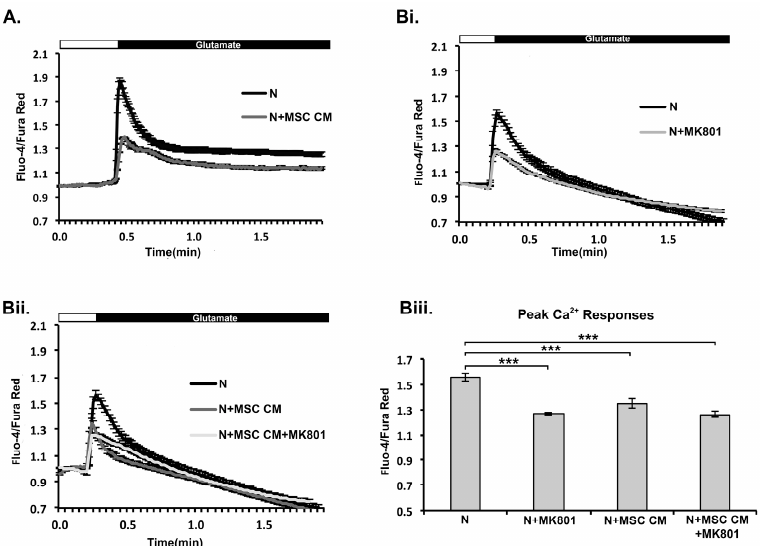
Figure 4. MSC CM-mediated neuroprotection in mouse cortical neurons is associated with reduced glutamate-induced Ca 2+ responses. DIV 9 neurons (N) were pre-treated with MSC CM (24 h) and glutamate-induced intracellular Ca 2+ levels were measured by Fluo-4 and Fura Red imaging. Perfusion of neurons with glutamate/glycine transiently increased Ca 2+ levels in control cells, while responses were reduced in MSC CM-treated cells ( A ). Addition of MK801 inhibited Ca 2+ responses in untreated ( Bi and Biii ), but not MSC CM-treated ( Bii and Biii ) cells showing that the effects of MSC CM were mediated through the NMDAR. Peak responses in Bi and Bii are also represented as a plot ( Biii ). Results shown are means ± SEM of triplicate samples from one representative of three independent experiments. *** p < 0.001, pairwise comparison by Student’s t -test ( A ), and multiple comparisons by one-way ANOVA with Bonferroni test ( B ).